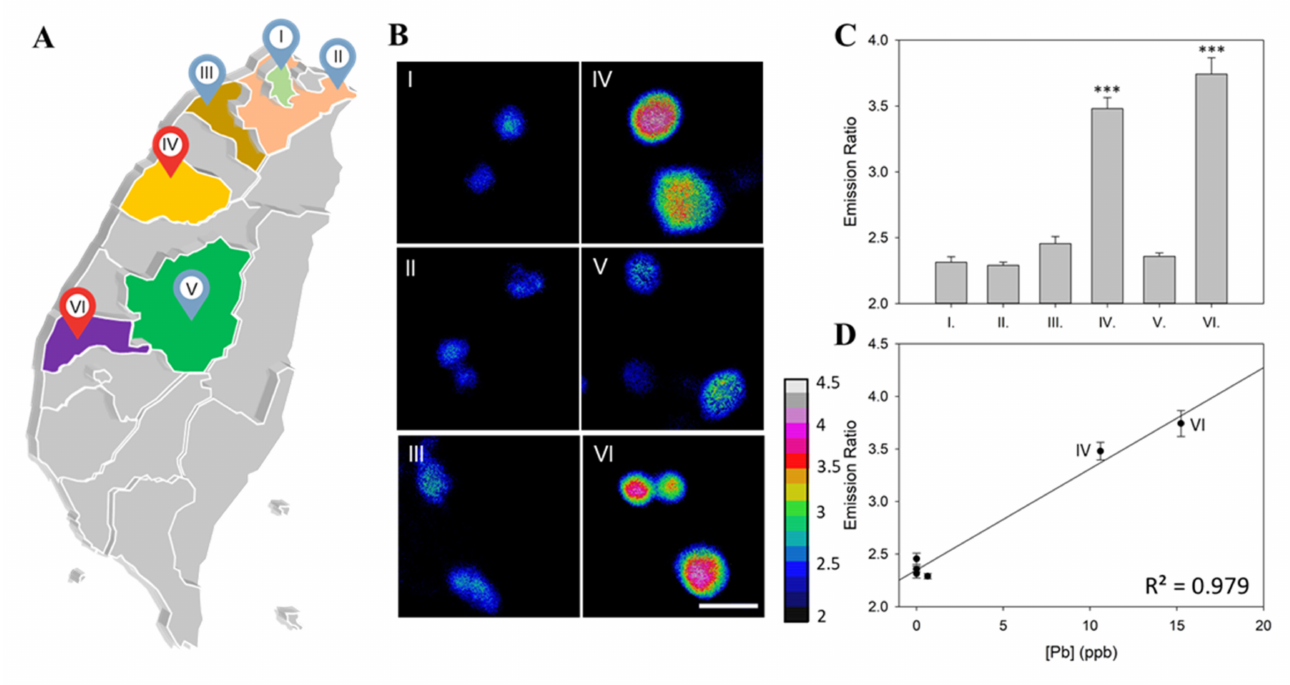
Figure 6. Measurement of Pb levels in selected environmental areas using the portable FRET-based Pb-sensing device. ( A ) Geographical regions where water samples were randomly collected in selected cities of Taiwan: I. Taipei city; II. New Taipei; III. Taoyuan; IV. Miaoli; V. Nantou; VI. Yunlin. ( B ) Representative ratio color images of samples I–VI analyzed using pMet-lead. ( C ) Average ratio for each geographical region compared to control water samples. The mean differences are described as significant at the 0.0005 (***) level. ( D ) pMet-lead FRET ratio values of Pb measurements from various geographic sources of water were validated by the general standard method (ICP-MS). Scale bar, 30 µ m. The ratio color bar is from 2 to